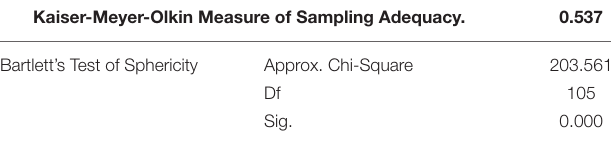
TABLE 7 | Principal component matrix arranged with decreasing order of loading